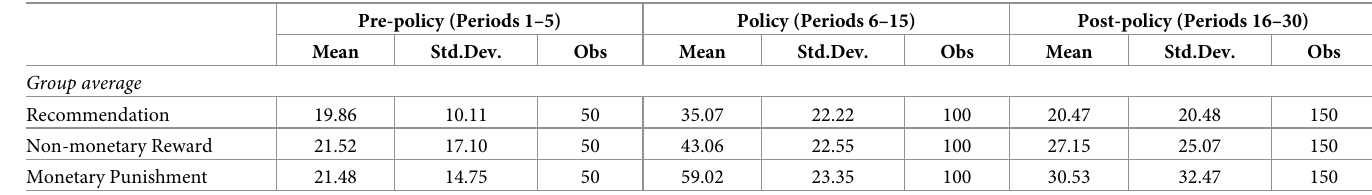
Table 2. Average